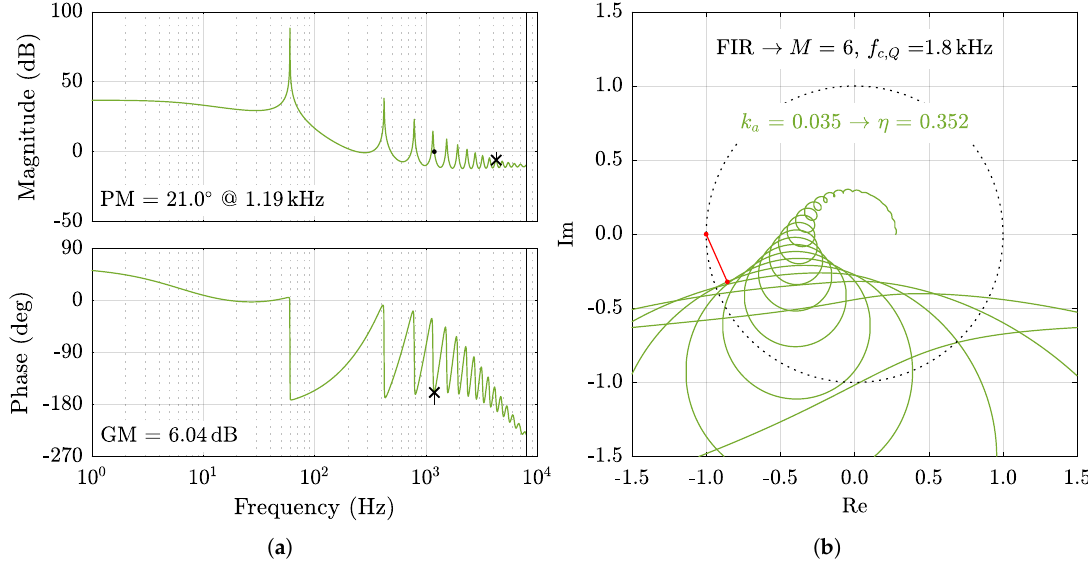
Figure 6. Nyquist and Bode diagram of final transfer function: ( a ) Bode diagram; ( b ) Nyquist